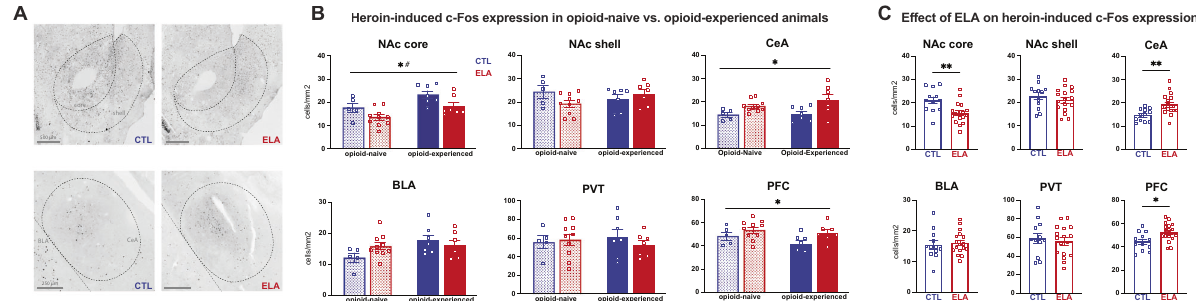
Fig. 5 ELA alters heroin-induced neuronal activation in a manner independent of prior opioid experience. ELA leads to blunted activation of NAc core but not the shell and leads to aberrant activation in CeA and PFC. ELA did not alter heroin-induced activity in BLA or PVT. A Representative images of c-Fos expression in NAc and CeA. B Heroin-induced c-Fos expression (cell density) in all animals separated by opioid history. C Heroin-induced c-Fos expression in all animals collapsed across opioid exposure conditions. *ELA vs. CTL P < 0.05; **ELA vs. CTL P < 0.005; # opioid-naive vs. opioid-experienced P < 0.05. experienced n = 7 CTL/7 ELA; naïve n = 5 CTL/10 opioid-naive, relative to when opioid-experienced Fig. 5B; inter- action: F (1,25) = 3.840, P = 0.0613; η p2 = 0.1331), and there was no